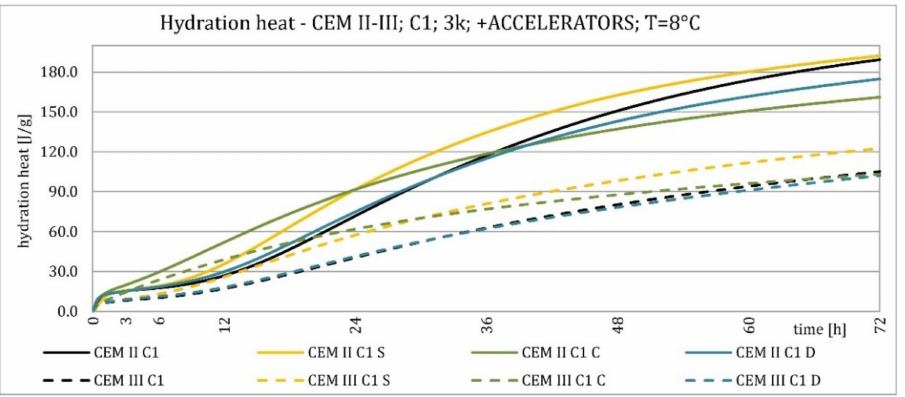
Figure 27. Hydration heat of C1 clinker-based cements CEM II/B-S, CEM III/A modified with accelerators at 8 ◦